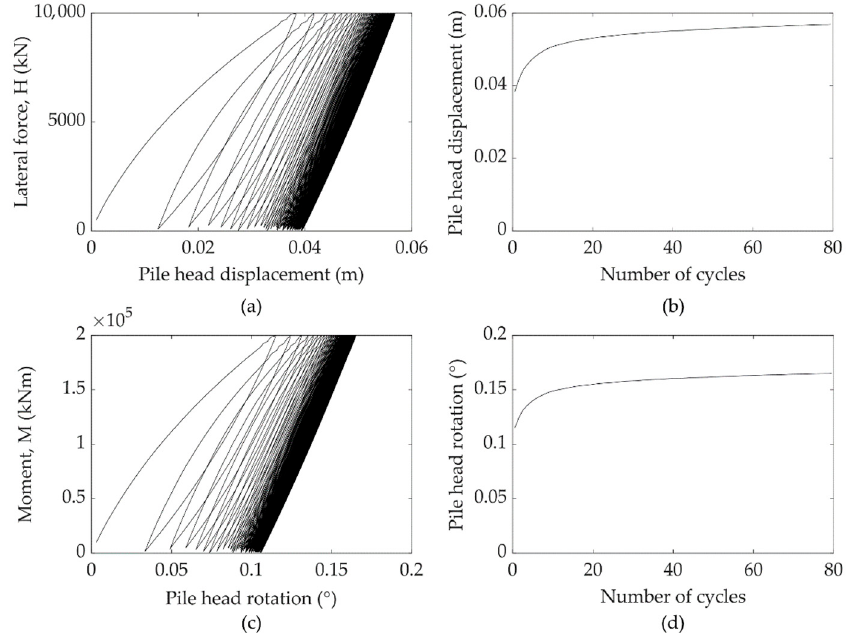
Figure 2. ( a ) Lateral load versus pile head displacement; ( b ) pile head displacement versus no. of cycles; ( c ) moment versus pile head rotation; ( d ) pile head rotation versus no. of cycles.